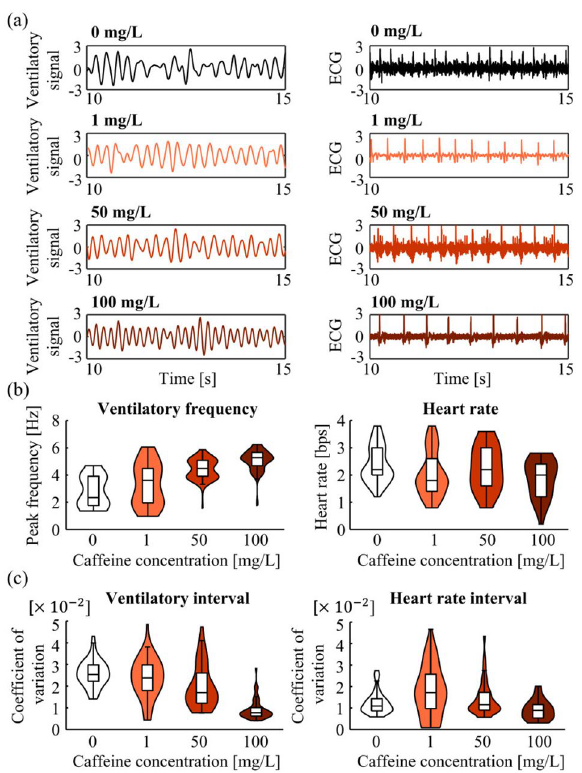
Figure 1. Frequency and variability analyses under restraint. Data were obtained from five individuals per caffeine concentration except for the 50 mg/L dose, for which four individuals were included as one did not meet the data inclusion criterion of surviving 72 h after the experiment. Violin plots of 0, 1, and 100 mg/L doses included 120 (five individuals, 120 s of measurement duration divided into 5 s segments) data points each; that of the 50 mg/L dose included 96 data points. The boxplots in the violin plot present the upper quartile, median, and lower quartile; whiskers extend from maximum to minimum value, excluding outliers. ( a ) Standardized ventilatory signals and ECG. ( b ) Distribution of ventilatory peak frequencies and heart rate at each caffeine concentration. ( c ) Distribution of the coefficients of variation calculated from the ventilatory signals and ECG at each caffeine